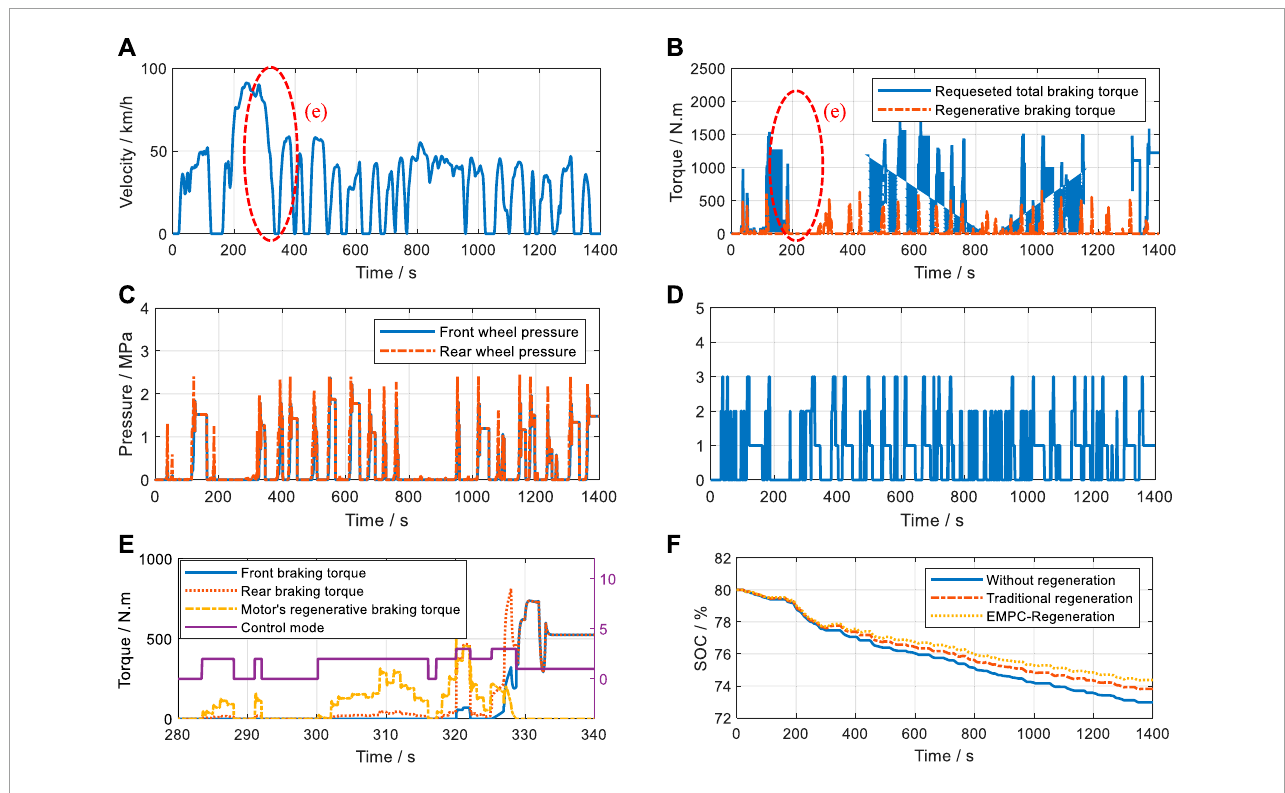
FIGURE 16 UDDS regeneration. (A) UDDS case. (B) The torque acting on the wheels. (C) Braking pressure. (D) Control mode. (E) The larger version of braking torque. (F) State-ofcharge.